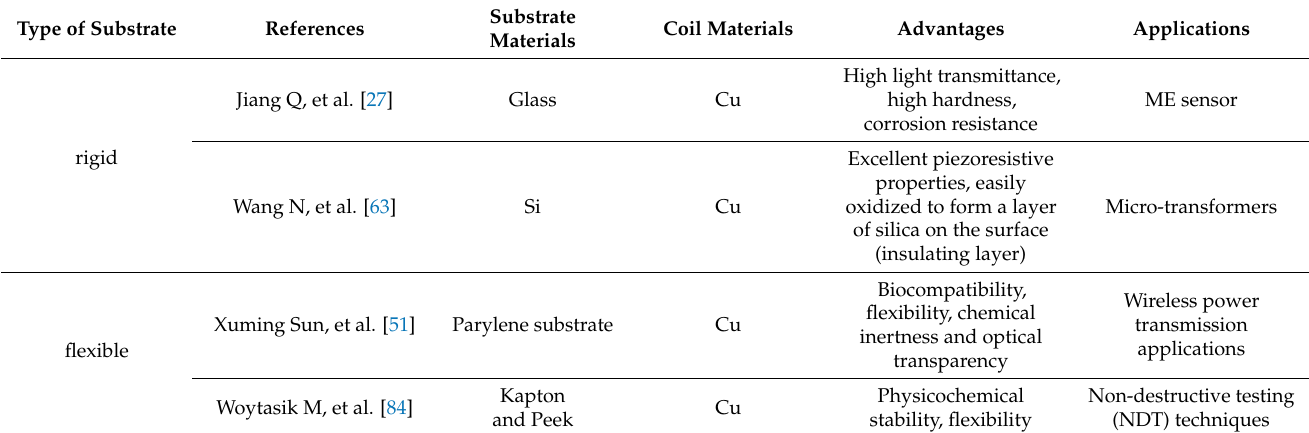
Table 3. Summary of coil applications with different substrate